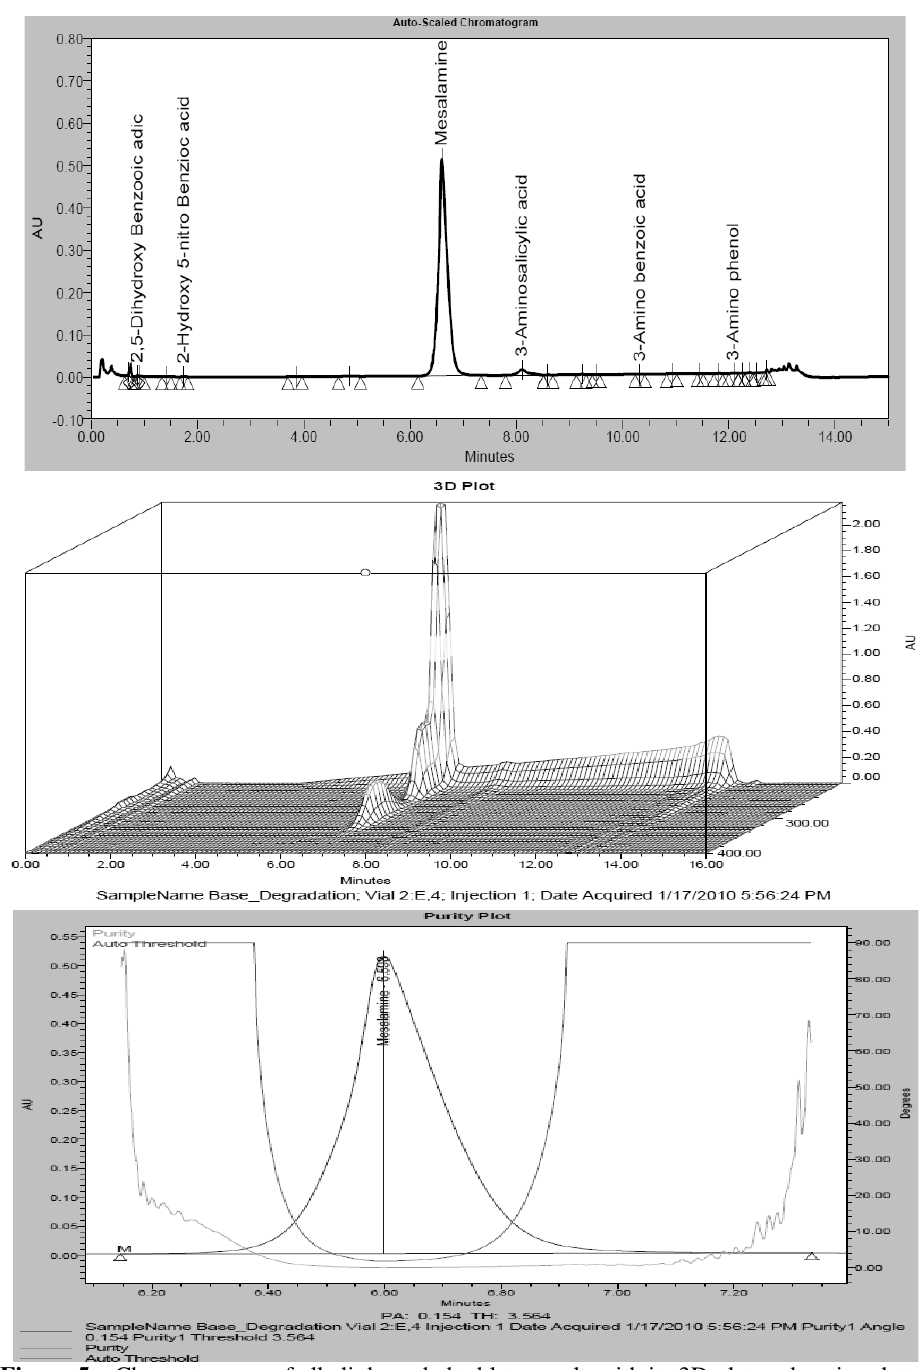
Figure 5. Chromatogram of alkali degraded tablet sample with its 3D plot and purity